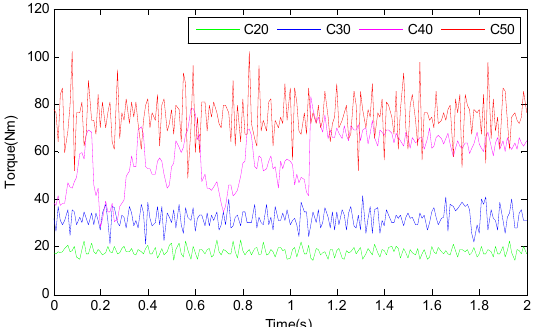
Figure 11. Speed chart of the rock drilling experiment.